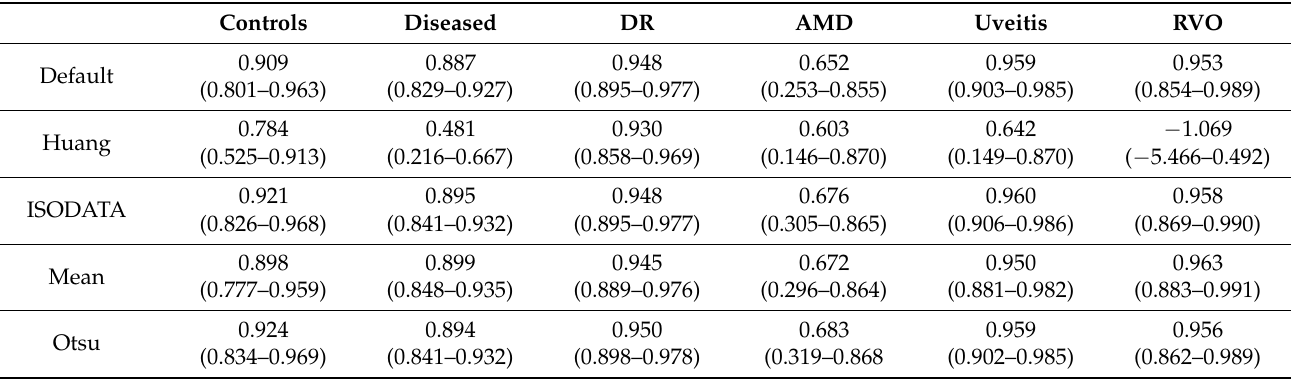
Table 2. Reliability analysis of the full retina slabs. The intraclass correlation coefficient and the respective 95% confidence interval are